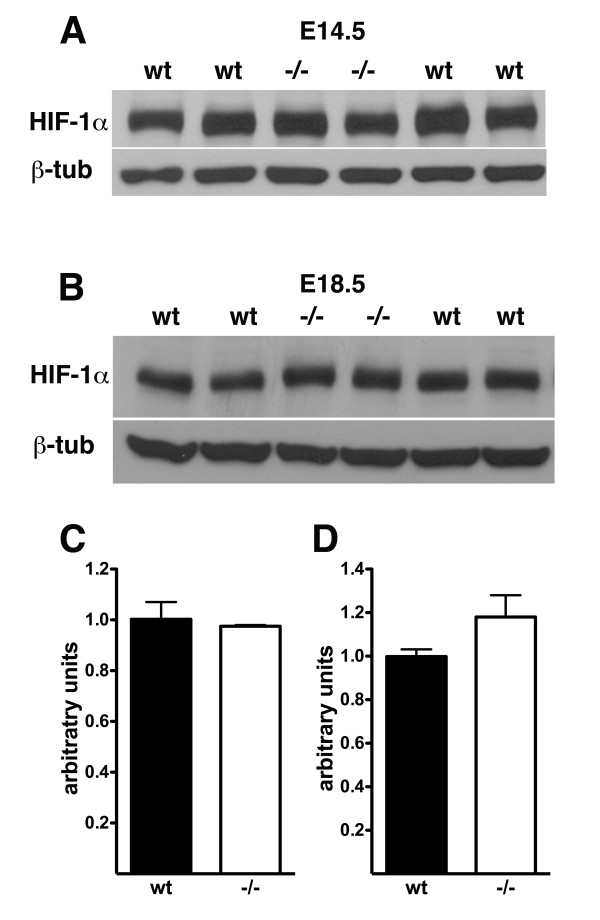
No change in HIF-1α levels in Psen1-/- embryonic brain. HIF-1α levels were determined by Western blotting of extracts from E14.5 (A) or E18.5 (B) brain from wild type (wt) or homozygous (-/-) Psen1 mutant mice. Representative experiments are shown. Lower panels show the same blots reprobed for β-tubulin. HIF-1α levels were quantitated as a ratio to β-tubulin at E14.5 (C) and E18.5 (D) (n = 4 wild type and 2 Psen1-/- at each age). There were no differences between wild type (wt) and Psen1-/- at either age (unpaired t-tests).